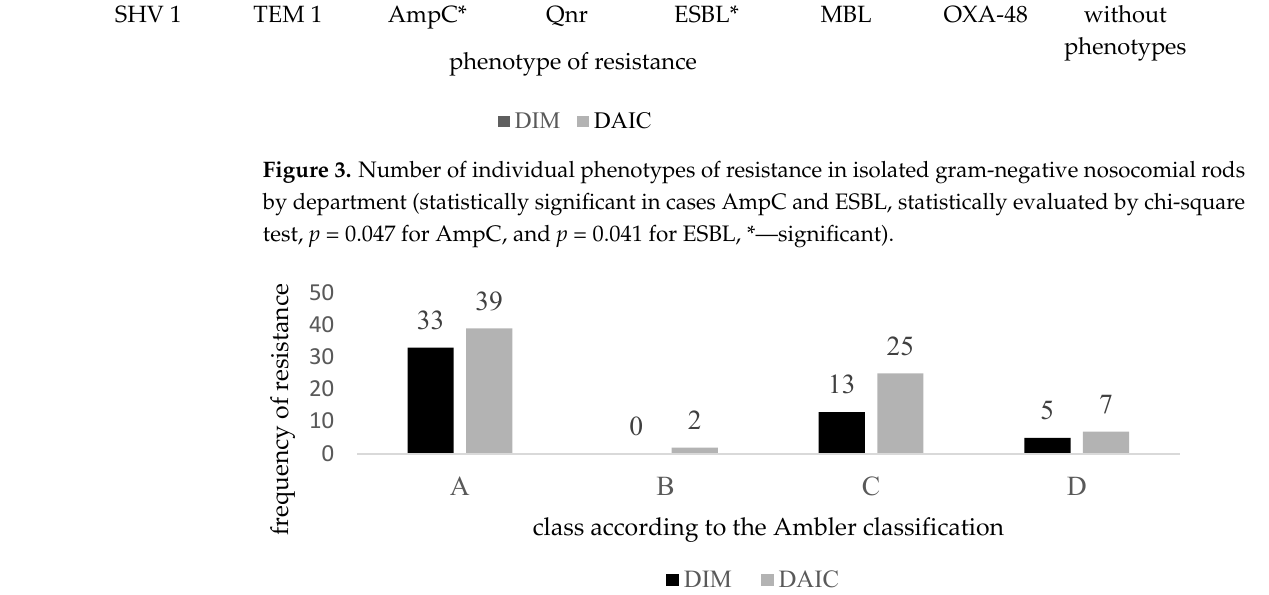
Figure 4. The number of individual types of β -lactamases after division into groups according to Ambler classification